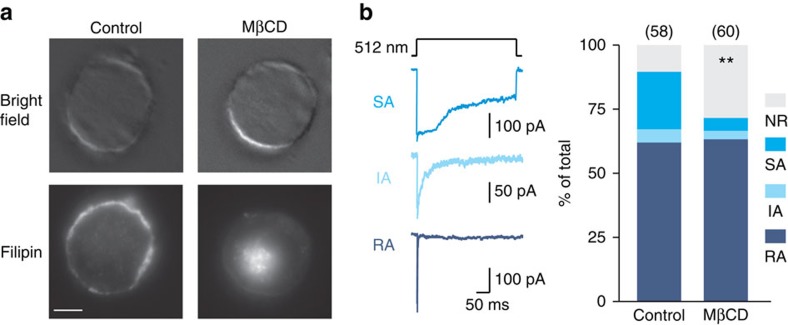
Cholesterol depletion alters mechanosensitivity of sensory neurons.(a) Bright field (top) and fluorescence (bottom) images of filipin-labelled neurons treated without (left) or with MβCD (right). Scale bar, 10 μm. (b) Left: representative traces of SA-, IA- and RA-mechanosensitive currents evoked by stimulating sensory neuron neurites. Right: stacked histograms showing the proportions of different mechano-gated currents observed in control and MβCD-treated neurons (χ2-test, P<0.01). Note the marked loss of SA-mechanosensitive current in MβCD-treated neurons (Fisher's exact test, P<0.01). NR, non-responsive to given displacement 512 nm. **P<0.01.